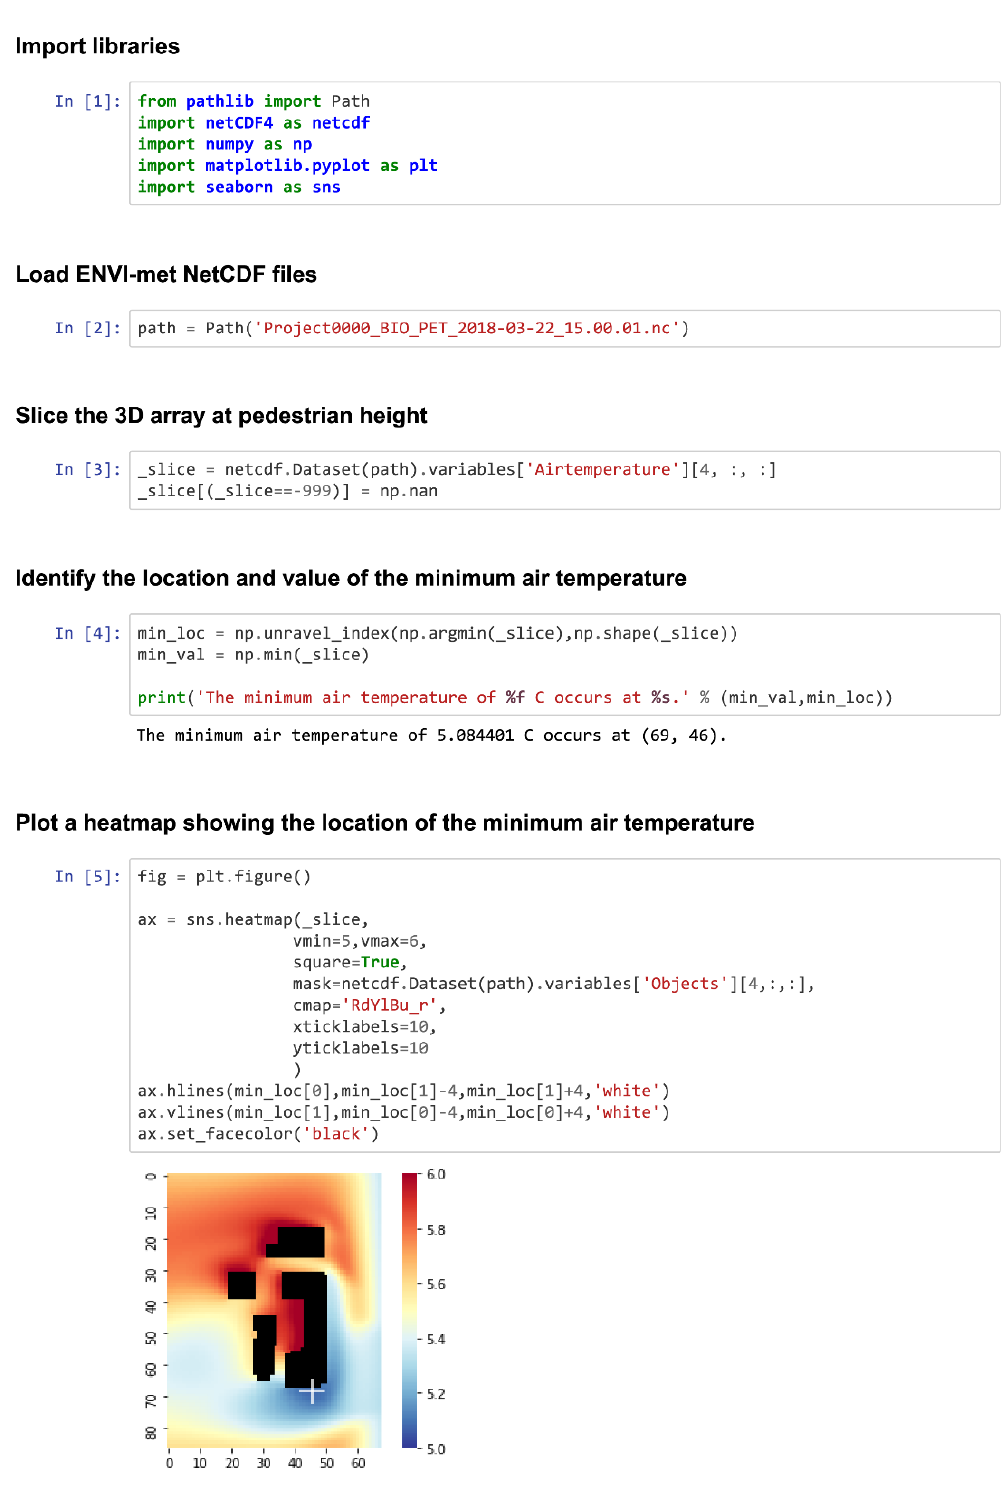
Figure 3. A Jupyter Notebook for identifying the location of the minimum air temperature in an ENVI-met simulation (white crosshairs).